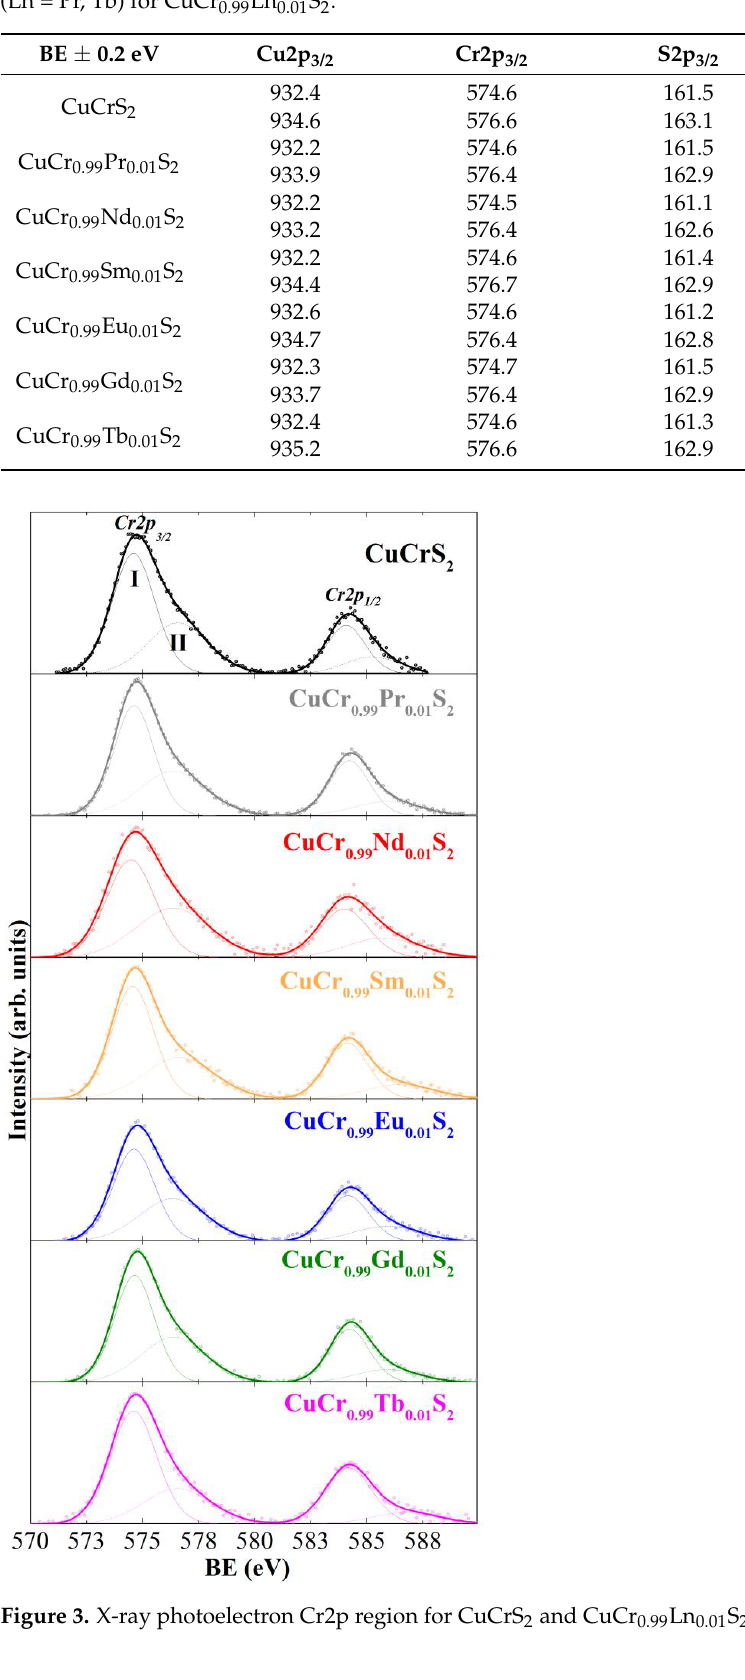
Table 2. Binding energy values of Cu2p 3/2 , Cr2p 3/2 , S2p 3/2 , Ln3d 5/2 (Ln = Nd–Gd) and Ln4d lines